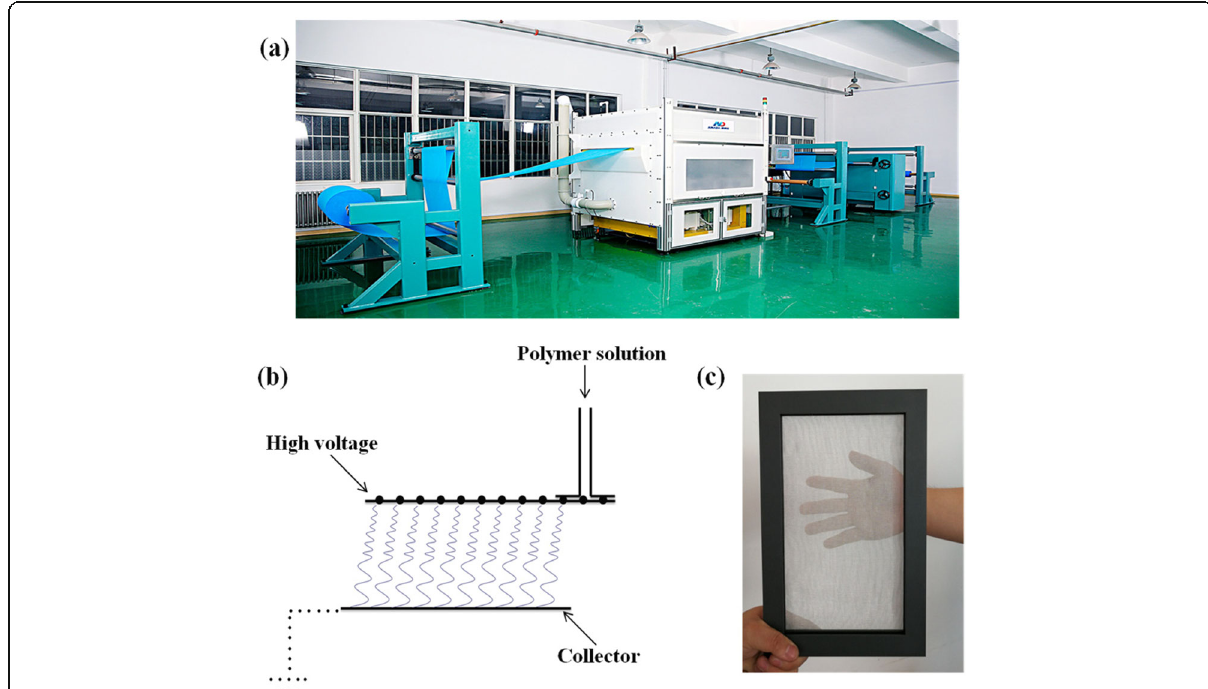
Fig. 1 Electrospinning equipment. a A picture of the electrospinning apparatus used in this work. b Schematic diagram of the electrospinning setup with rotary bead-wire spinnerets. c The nanofiber membrane in this air filter is a sample produced by the electrospinning apparatus